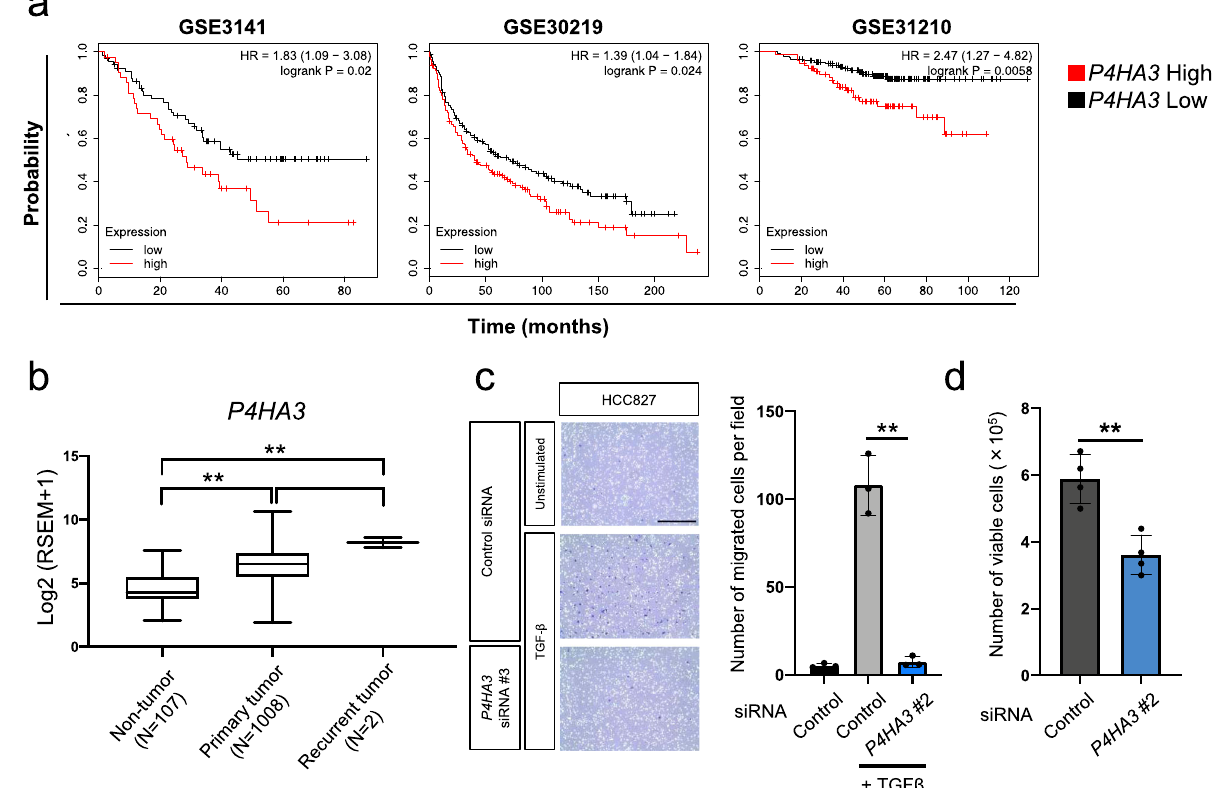
Fig. 6 Effect of P4HA3 depletion on cell migration and growth in vitro. a Association between P4HA3 and prognosis in patients with non-small cell lung cancer. b Box-and-whisker plot of P4HA3 mRNA levels in non-tumor ( n = 107), primary tumor ( n = 1008), and recurrent tumor tissues ( n = 2) from the lung cancer dataset in the Cancer Genome Atlas. ** P < 0.01. c Effects of P4HA3 siRNA on the migratory activity in TGF- β -treated HCC827 cells. HCC827 cells were cultured in the presence of 2 ng/mL TGF- β for 2 – 5 weeks to induce EMT and transfected with P4HA3 siRNA for 48 h prior to the cell migration assay. Cells were observed by bright fi eld microscopy at ×100 magni fi cation. Scale bar, 500 μ m. Data are presented as mean ± SD. ** P < 0.01. d Effect of P4HA3 knockdown on cell viability in A549 cells. Cells were enumerated 72 h after transfection with P4HA3 siRNA. Data are presented as mean ± SD. ** P <